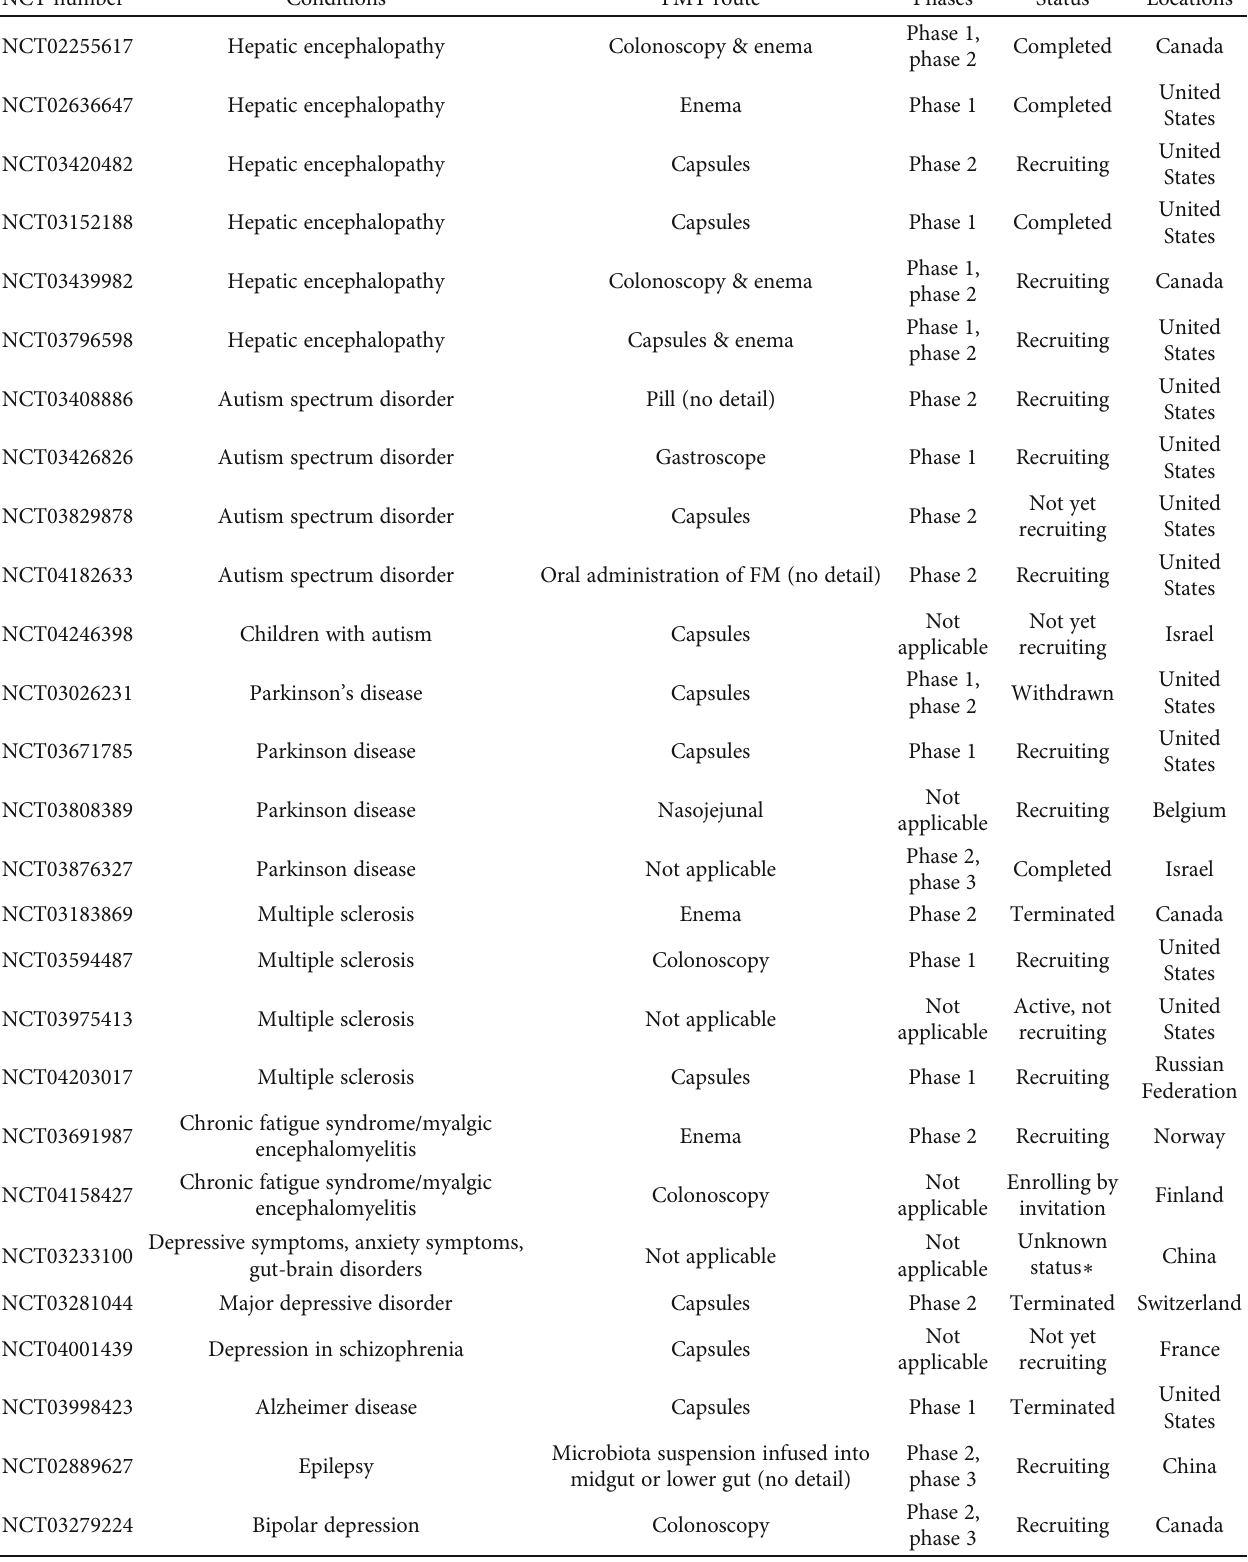
Table 3: Clinical trials of FMT involving in nervous and mental